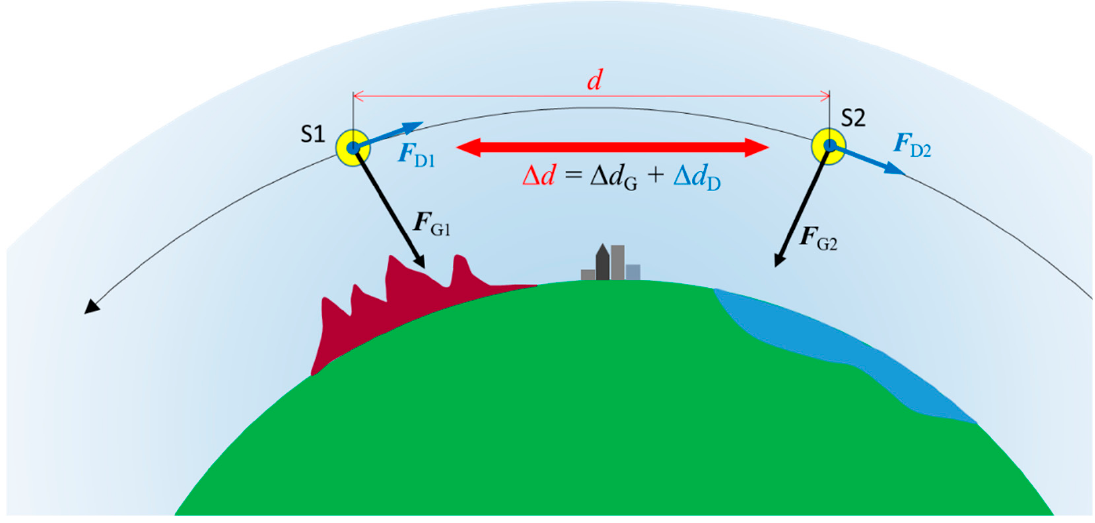
Figure 1. Principle of the low-low satellite-to-satellite tracking technique.